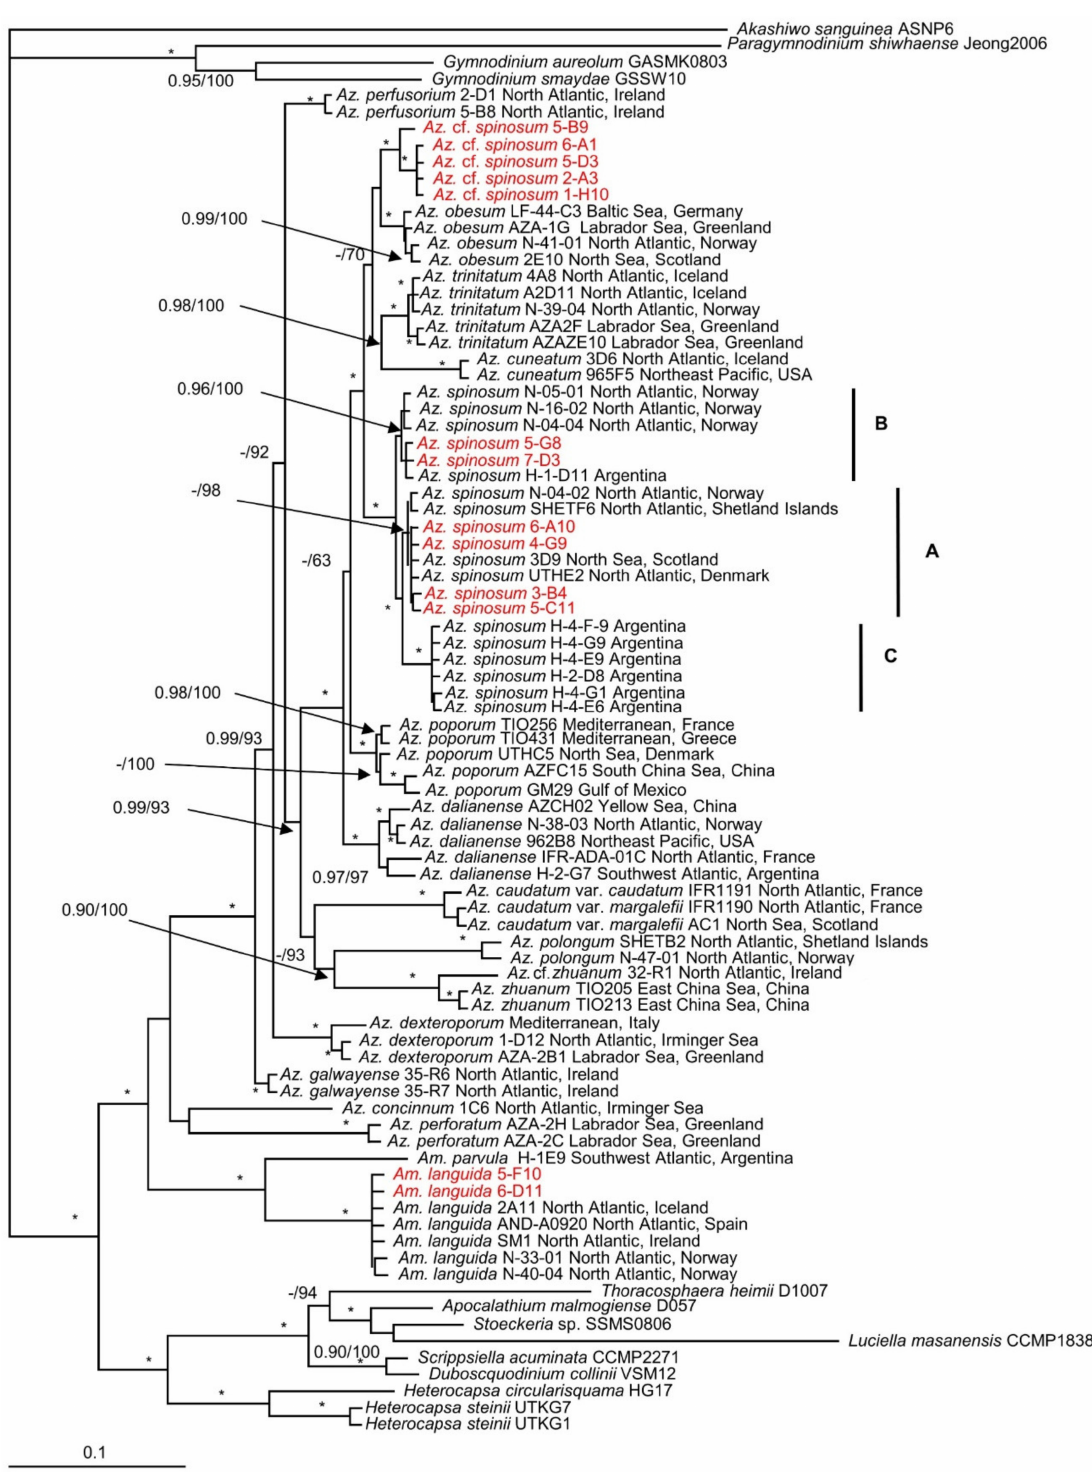
Figure 2. Molecular phylogeny of Azadinium and Amphidoma inferred from concatenated small subunit (SSU), internal transcribed region (ITS)-5.8S, and partial large subunit (LSU) rRNA gene sequences using Bayesian inference (BI). New sequences of Azadinium spinosum , Az. cf. spinosum , and Amphidoma languida are indicated in red. Ribotypes of Az. spinosum are marked with A, B, and C. Scale bar indicates the number of nucleotide substitutions per site. Numbers on branches are statistical support values (left, Bayesian posterior probabilities; right, maximum likelihood (ML) bootstrap support values). Bootstrap values >50% and posterior probabilities (pp) above 0.9 are shown. Asterisks (*) indicate maximal support (pp = 1.00 in BI and bootstrap support = 100% in ML,